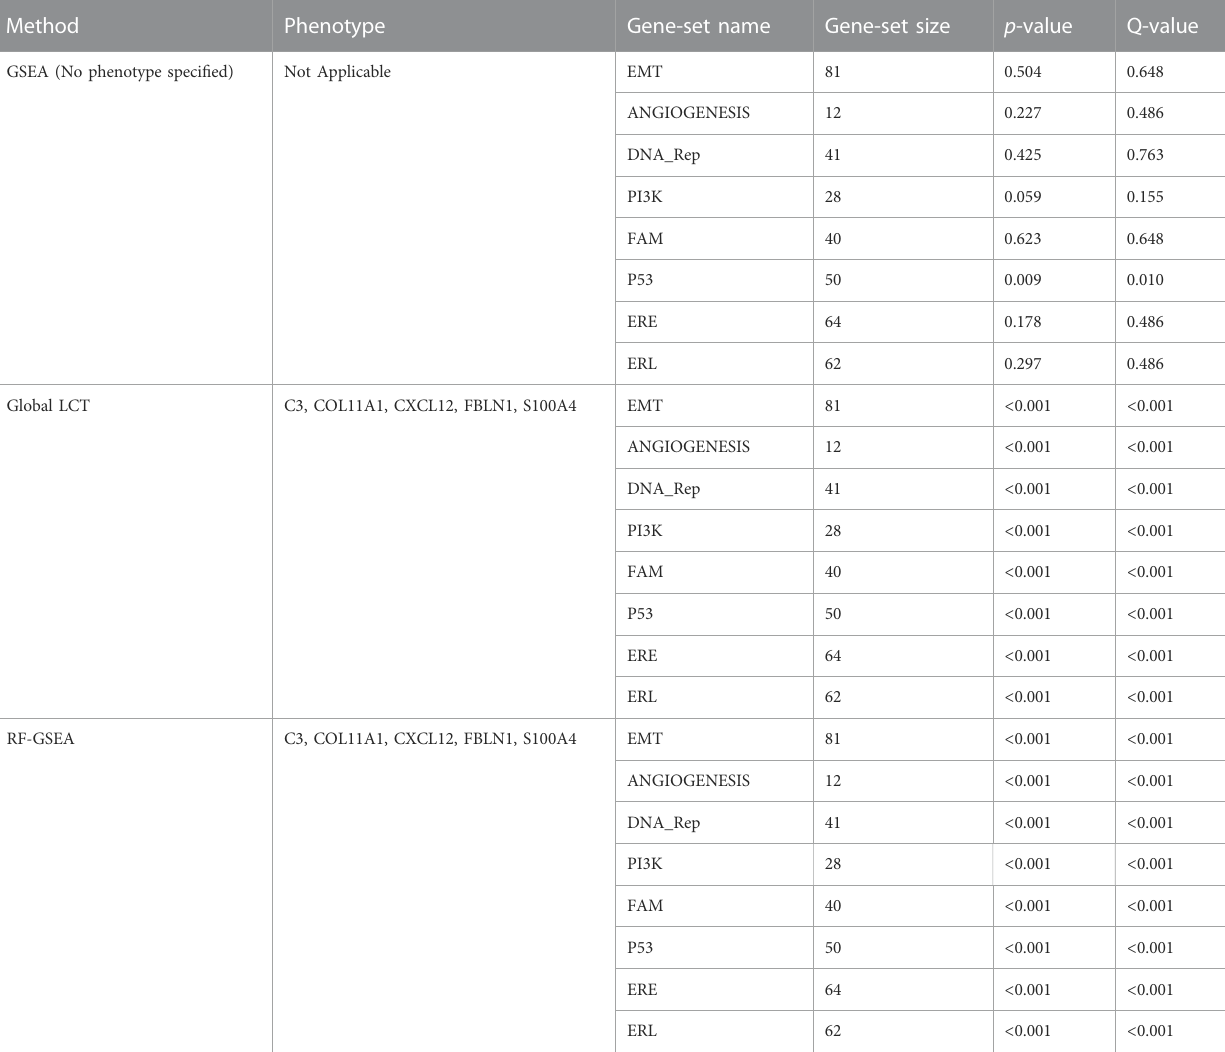
TABLE 1 An evaluation of cancer hallmark gene-sets associated with fi ve continuous phenotypes C3, COL11A1, CXCL12, FBLN1, and S100A4 using the aspatial methods including GSEA, LCT, and RF-GSEA on a single cell breast cancer